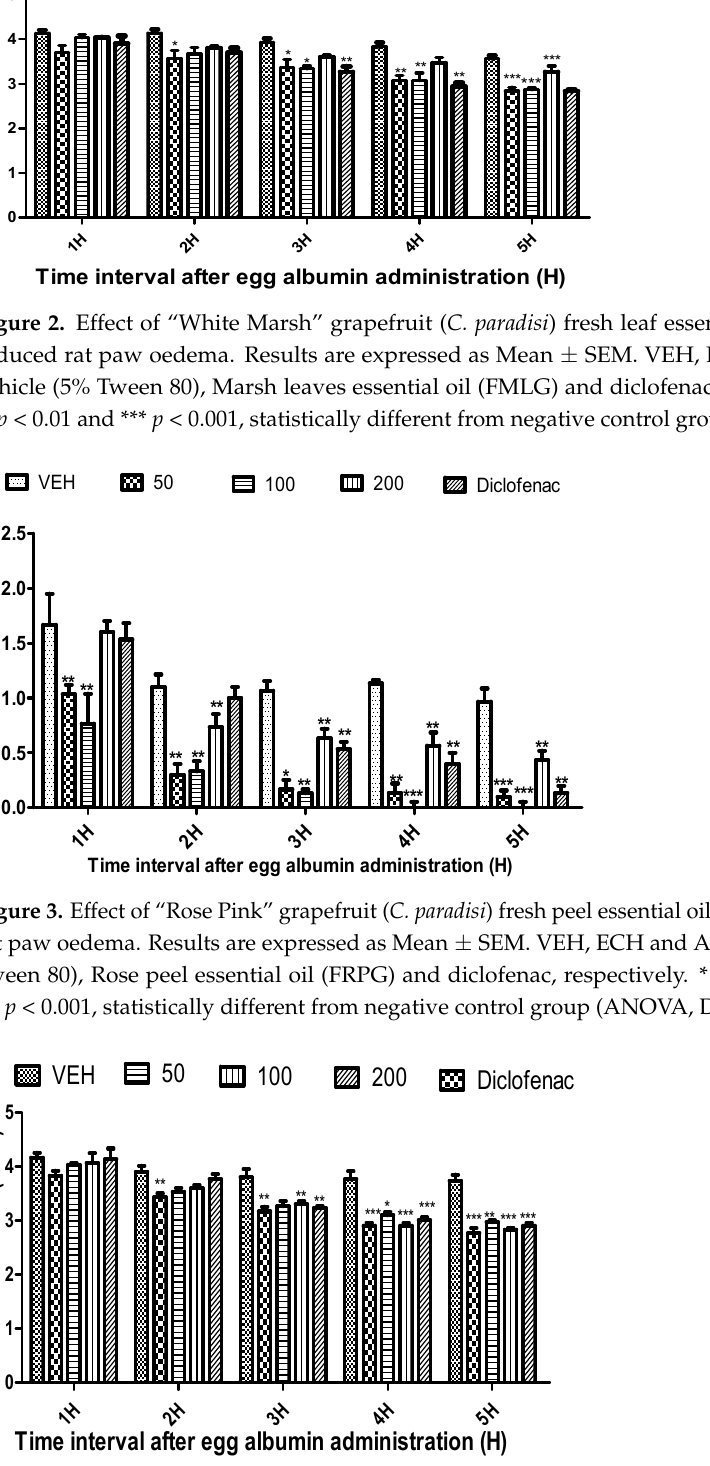
Figure 5. Effect of “Ruby Red” grapefruit ( C. paradisi ) fresh peel essential oil on egg albumin-in- duced rat paw oedema. Results are expressed as Mean ± SEM. VEH, ECH and ASA represent ve- hicle (5% Tween 80), Ruby peel essential oil (FSPG) and diclofenac, respectively. * p < 0.05, ** p < 0.01 and *** p < 0.001, statistically different from negative control group (ANOVA, Dunnett’s). 1 H